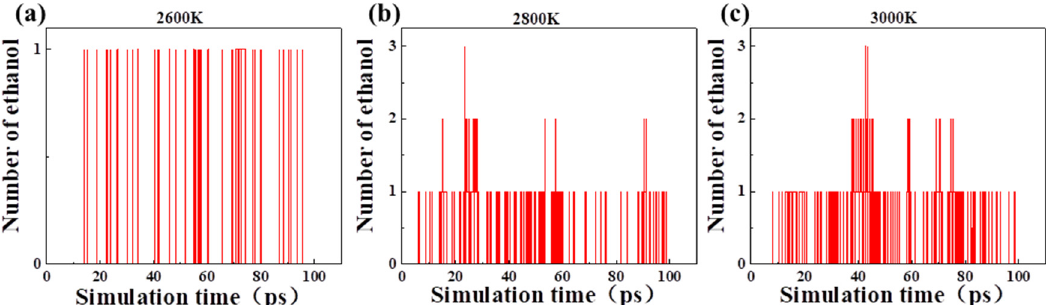
Figure 8. Production of ethanol molecules in the pyrolysis of cellobiose at different temperatures: ( a ) 2600 K, ( b ) 2800 K and ( c ) 3000 K.